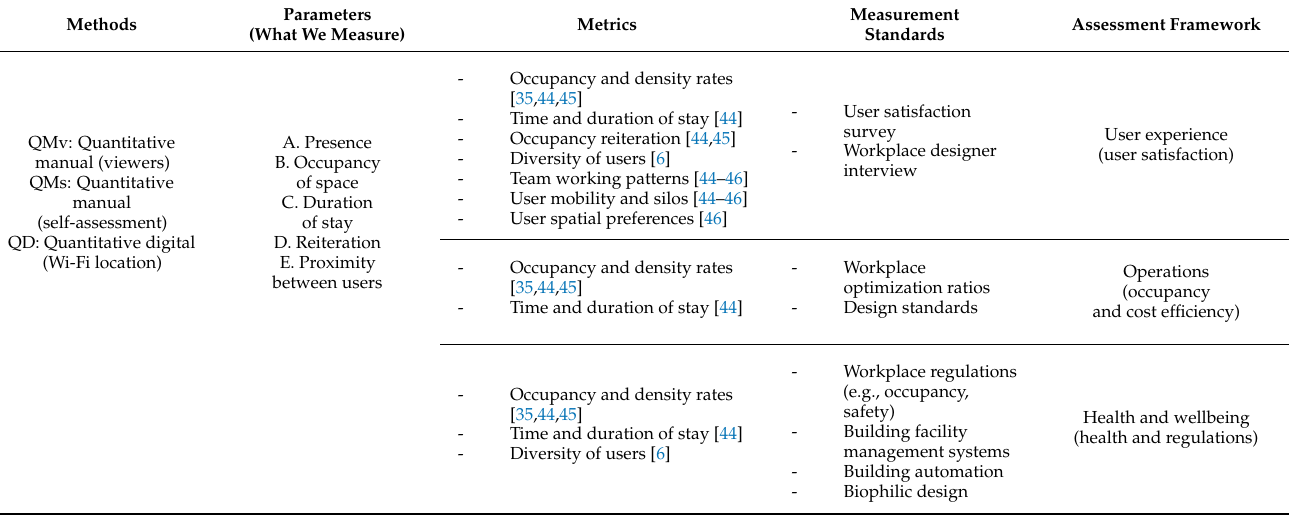
Table 1. Conceptual analysis assessment framework development for the methodology. Methods Parameters (What We Measure) Metrics Measurement Standards Assessment